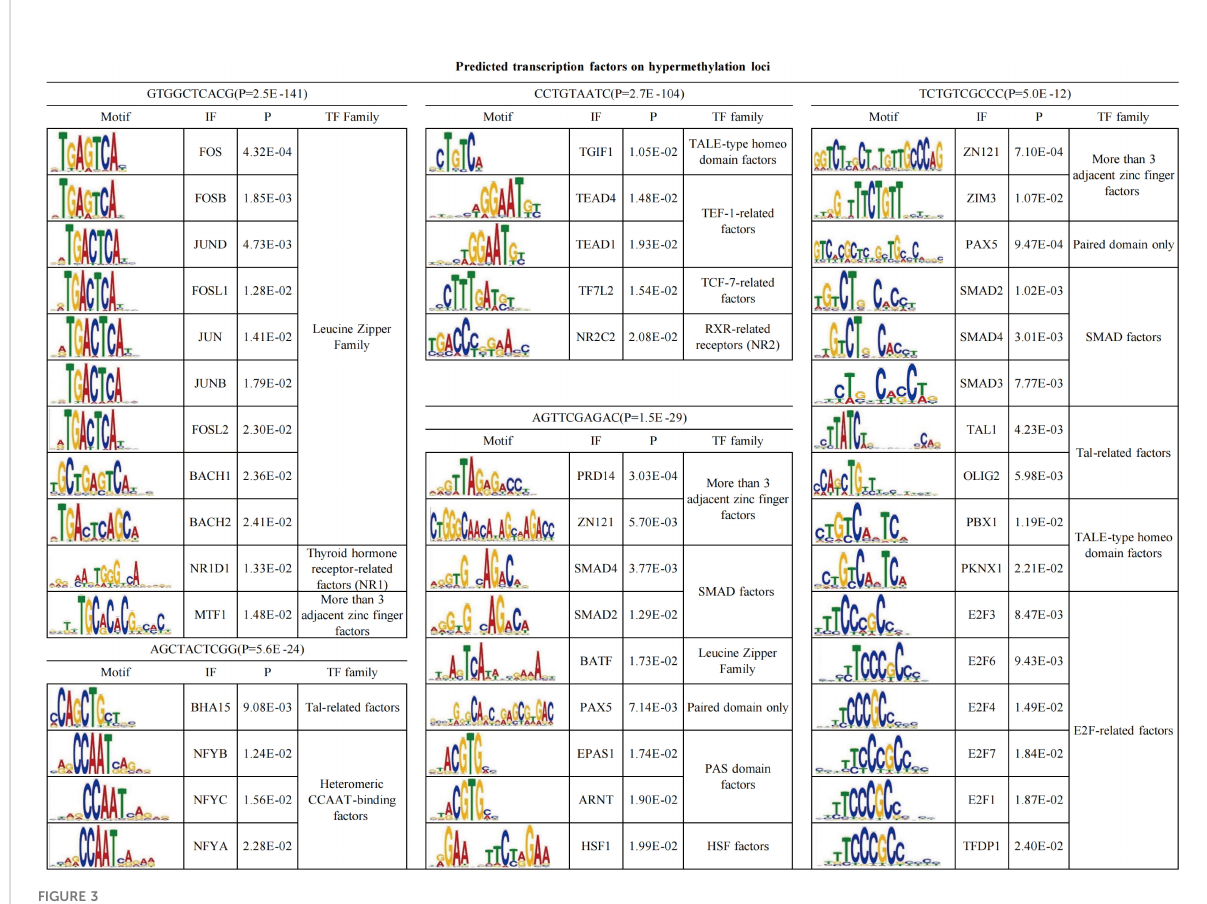
FIGURE 3 Predicted transcription factors on hypermethylation loci using